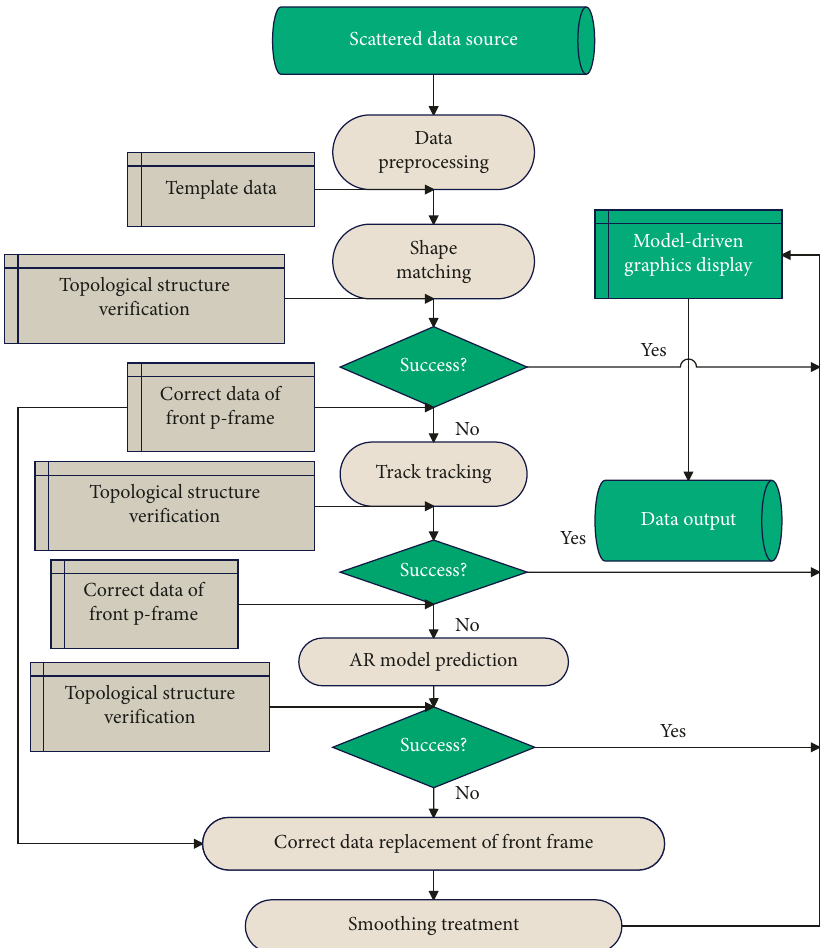
Figure 6: Flowchart of the scattered data processing